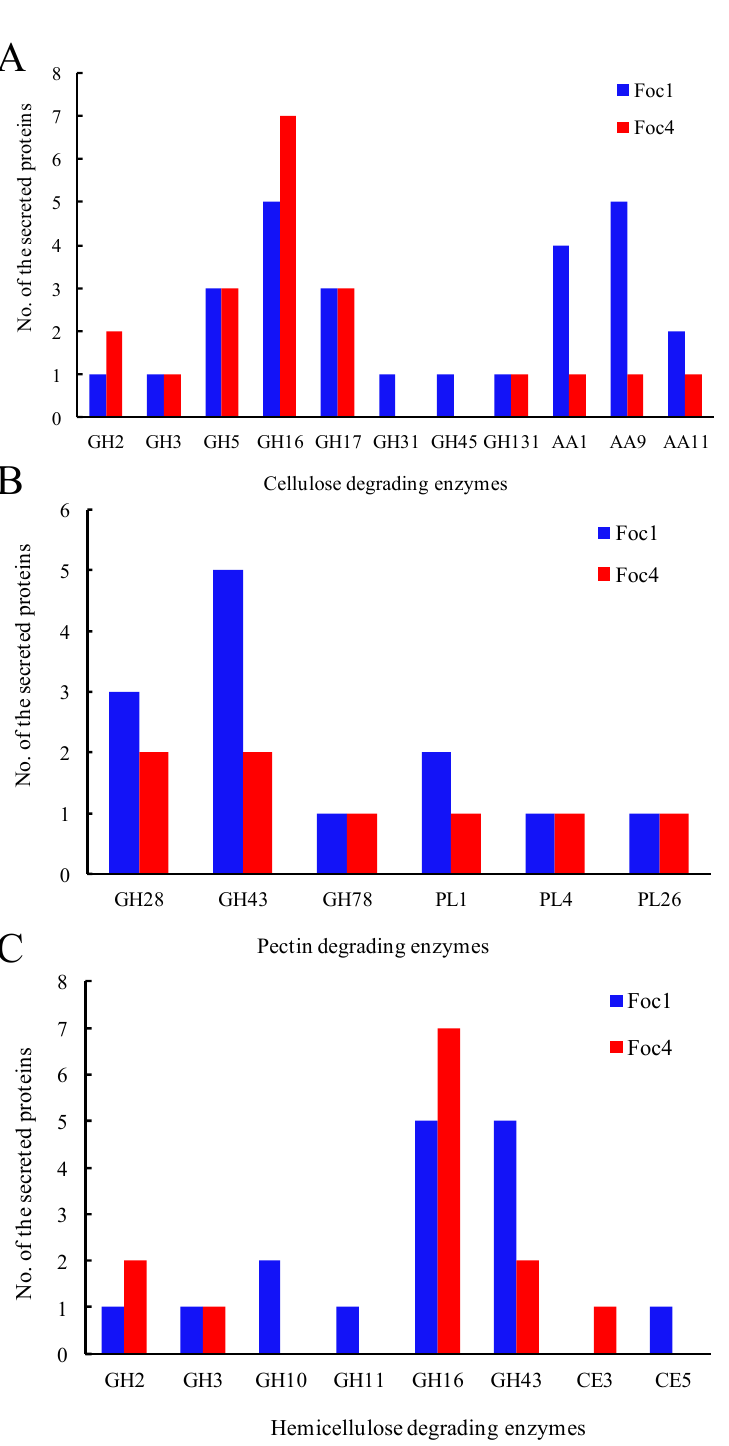
Figure 4. Comparison of cell wall-degrading enzymes between Foc1 and Foc4. ( A ), cellulose-degrading enzymes; ( B ), pectin degrading enzymes; ( C ), xylan degrading enzymes.